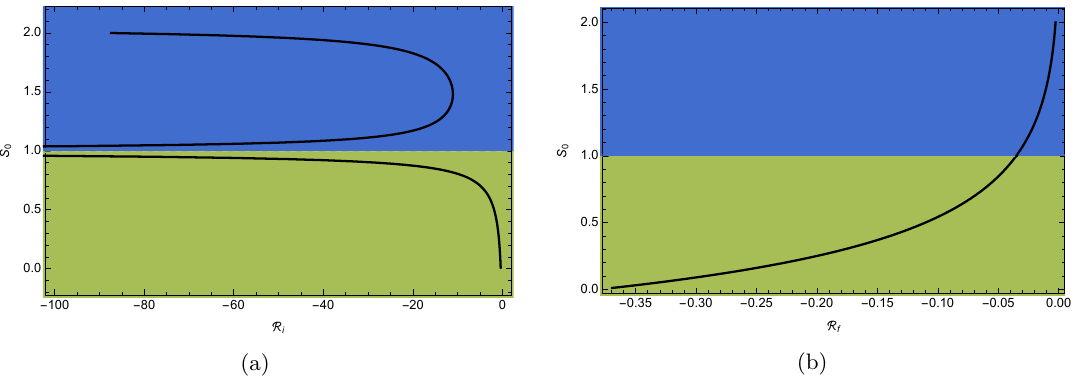
and W LL space of solutions. (b): two flows of type W LL Figure 42 . (a): type W LL 1 , 1 1 , 2 at ϕ = 2 . 2 (red vertical dashed line) near the border (a point where the red horizontal and vertical 0 dashed lines are joined). The blue curve with two bounces belongs to the W LL with one bounce is a W LL solution. 1 , 1